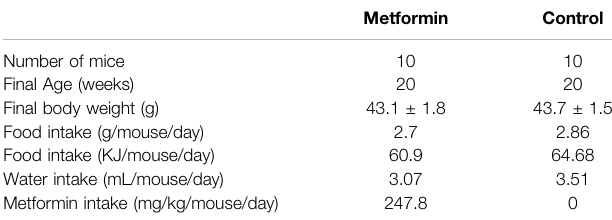
TABLE 1 | Basic characteristics of mice in metformin and control groups.